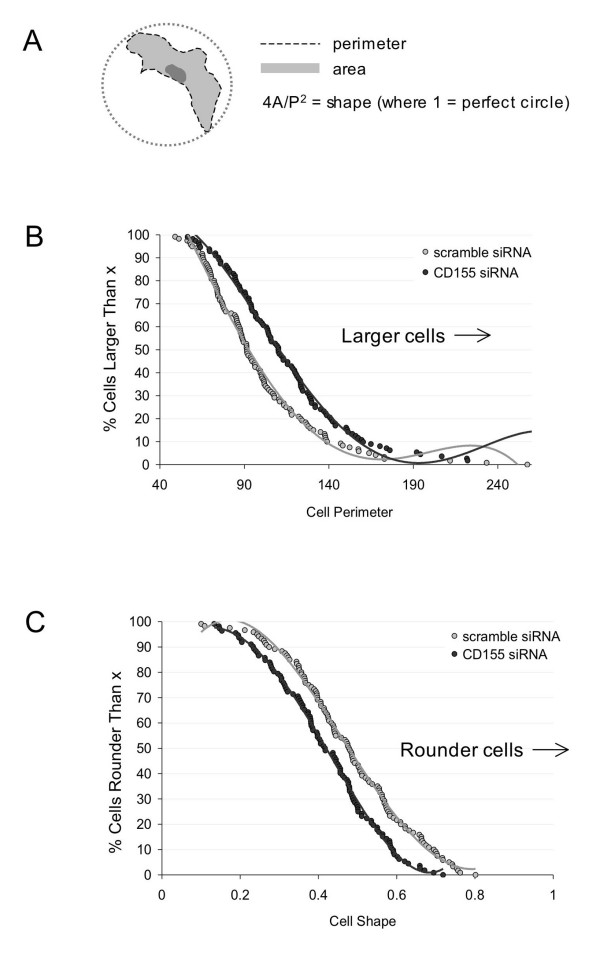
CD155 regulates cellular morphology. HT1080 cells were transfected with siRNA targeting CD155 or with a scrambled control duplex and plated on matrigel after 48 h. Cells were fixed and immunostained for CD155 expression before images were acquired for morphometric analysis. (a) Schematic showing measurement parameters. (b) Chang plot showing cell perimeter measurements. Perimeters values are expressed as percent of the average control perimeter. As a population, CD155 knockdown cells (dark circles) exhibited a significant increase in perimeter compared to controls (light circles). (c) Chang plot showing cell shape measurements. Cell shape was defined using the equation (4 × cell area) / cell perimeter2, where 1 indicates a perfect circle and smaller values indicate a more irregular shape. CD155 knockdown cells (dark circles) were more irregular in shape than scrambled controls (light circles). Perimeter: Δ avg = +18%; shape: Δ avg = -13%;p < 0.001, t-test; n = 120 scramble siRNA and 112 CD155 siRNA.